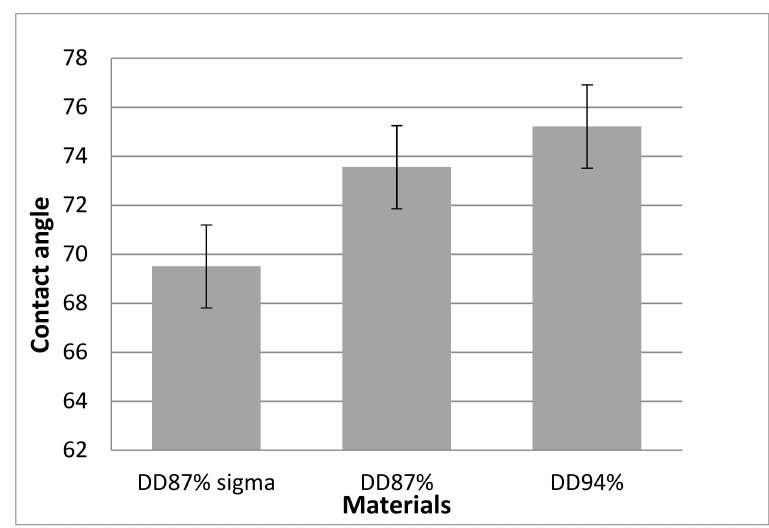
Figure 6. Contact angle for the tested chitosan membranes.